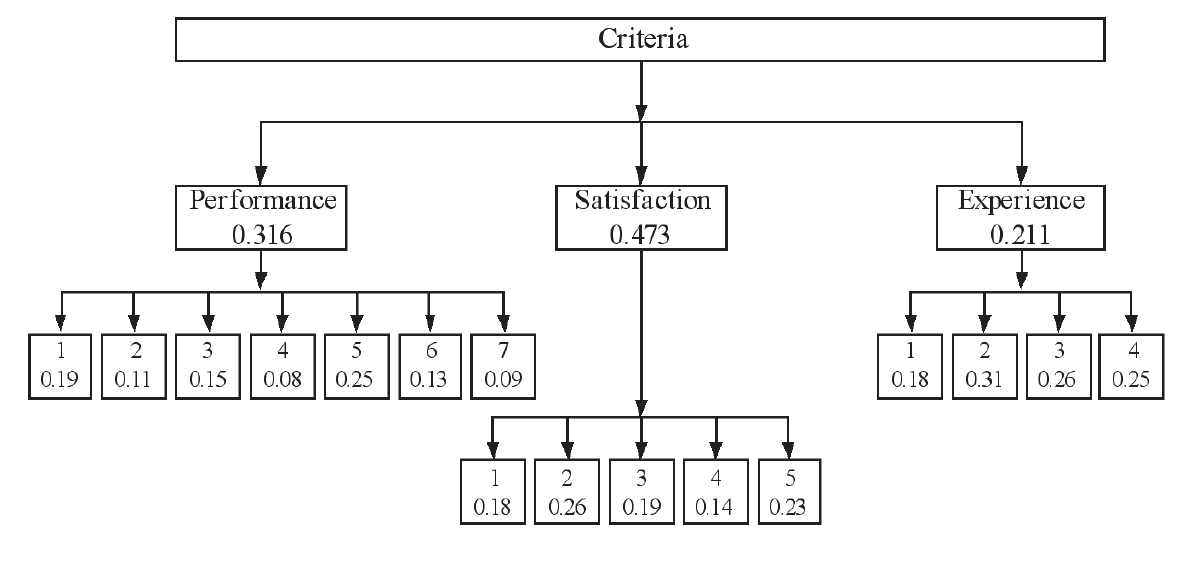
Figure 5: Weights of criteria and